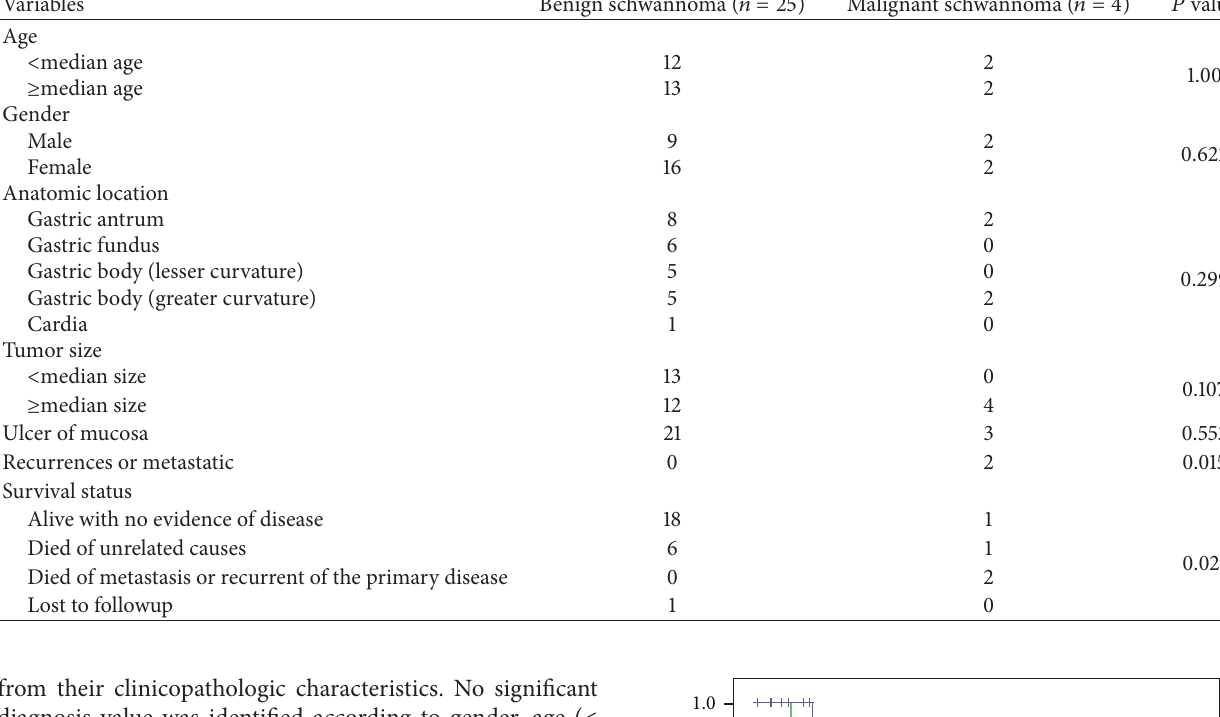
Table 3: Comparison of clinical and pathologic variables between benign and malignant gastric schwannoma.